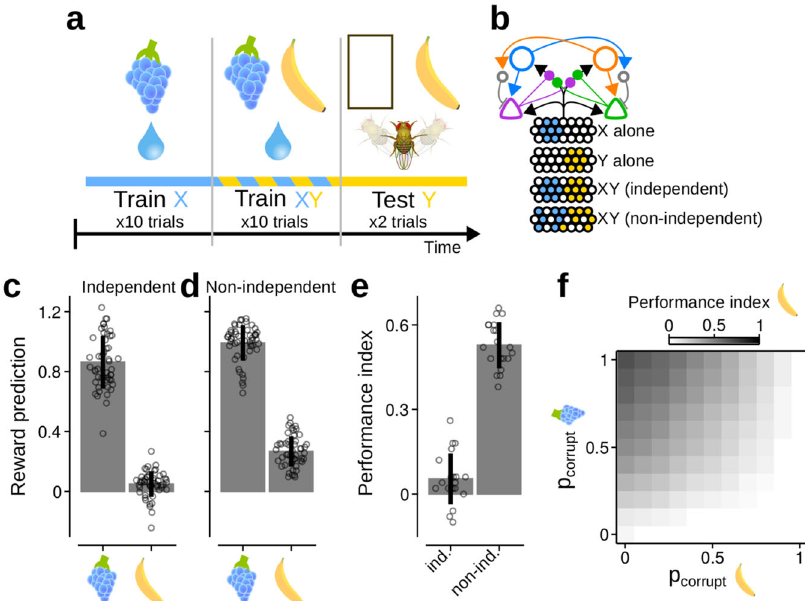
Fig. 6 The absence of blocking does not imply the absence of reinforcement prediction errors. a Schematic of the protocol used to simulate blocking experiments. b Schematic of KC responses to the two conditioned stimuli, X and Y, when presented alone or as a compound. c , d Reinforcement predictions (RPs) for the two stimuli, averaged over the two test trials. Bars and whiskers: mean ± standard deviation. Circles: RPs from individual simulation runs, n = 50. Source data provided in Source data fi le. c Stimuli elicit independent KC responses during compound training. d Y gains a positive RP when KC responses to each stimulus are corrupted ( p X ¼ 0 : 8, p Y ¼ 0 : 2). e Performance indices during the test phase. When stimuli elicit cor cor independent KC responses (ind.), the weak RP for Y results in little choice preference for Y over the null option. When KC responses are corrupted (non- ind.), the positive RP for Y results in a relative strong preference for Y over the null option. Bars and whiskers: mean ± standard deviation, n = 20. Circles: PIs from batches of 50 simulation runs. Source data provided in Source data fi le. f Gradations in the blocking effect result from varying degrees of corruptions to X or Y during the compound stimulus training